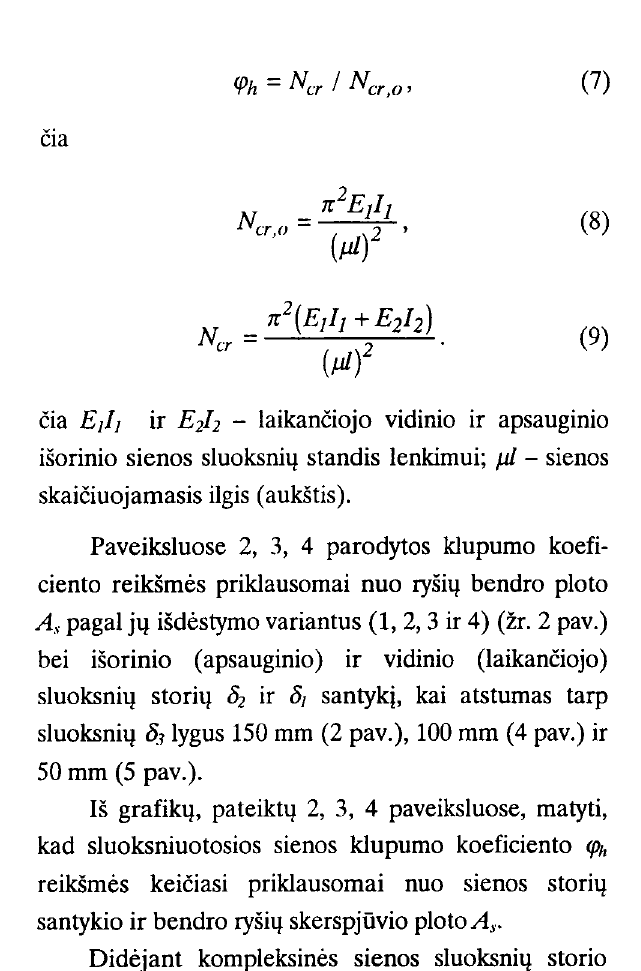
2 pav. Klupumo koeficiento (/Jh priklausomybe nuo ry8iq bendro ploto A., pagal ry8iq isdestymo variantus: a - 120- 150-60, b -120-150-100; c -120-150-120 serijoms * ; 4- .x. Variantai 1 - + ; 2- •; 3 - Fig 2. Relationship between buckling coefficient (/Jh and total area A .• of ties according to 1-2-3-4 variants of situation of ties: a -120-150-60, b- 120-150-100; c- 120- 150-120.